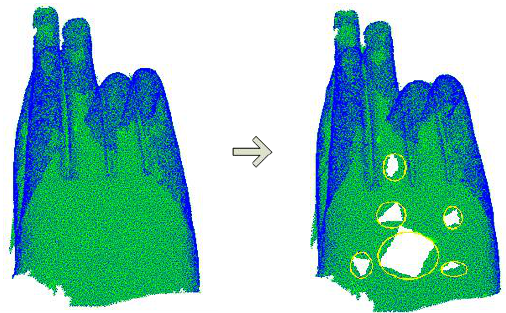
Figure 16. Manual removal of the point cloud data, which included damage.